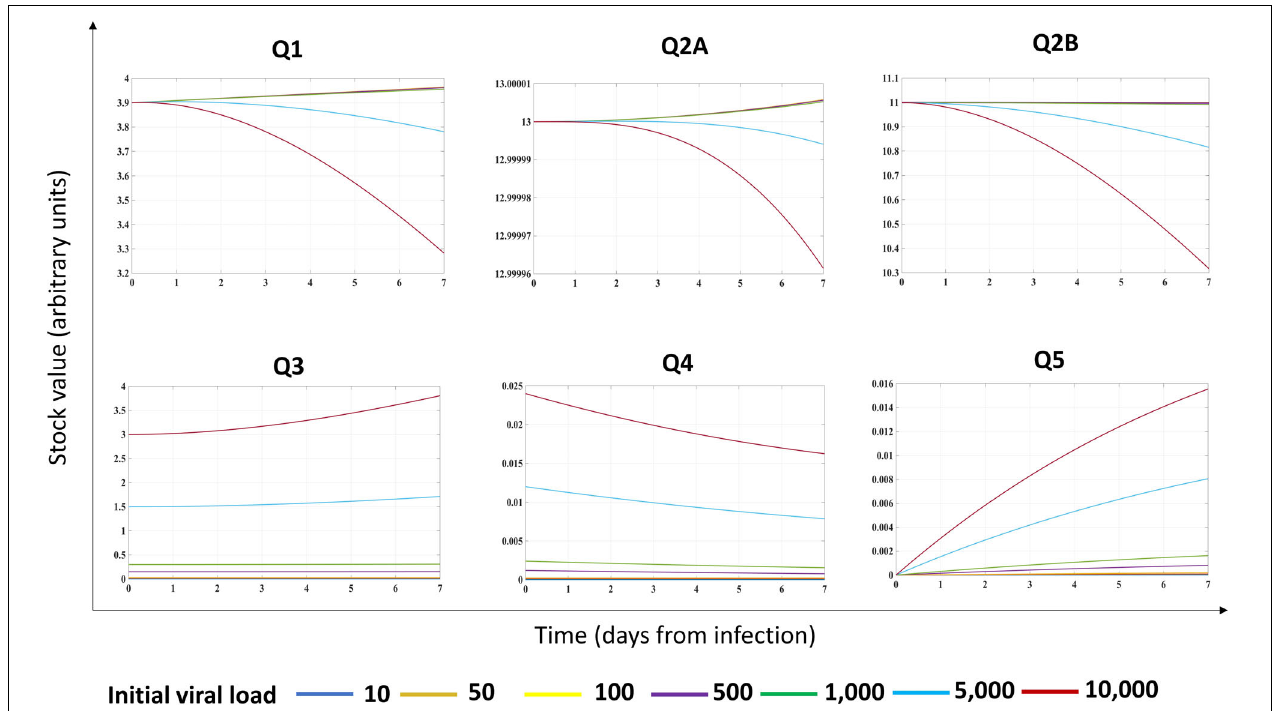
FIGURE 3 | Effects of initial viral load on the energy dynamics of a cell infected by a (+)ssRNA virus. Stock values, expressed in ATP-eq (arbitrary units chosen as proxy), are shown from Day 0 though Day 7 as a function of different initial viral loads (indicated at the bottom with different color codes). Evolutionary pattern for each stock was not